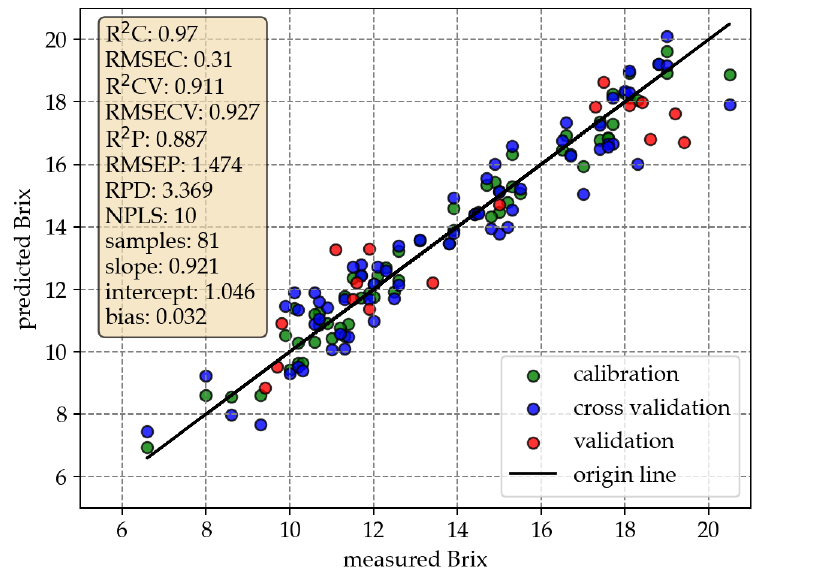
Figure 3. Correlation plot based on OpenVNT Vis29 spectral data including specific results. Where applicable, the unit % Brix is